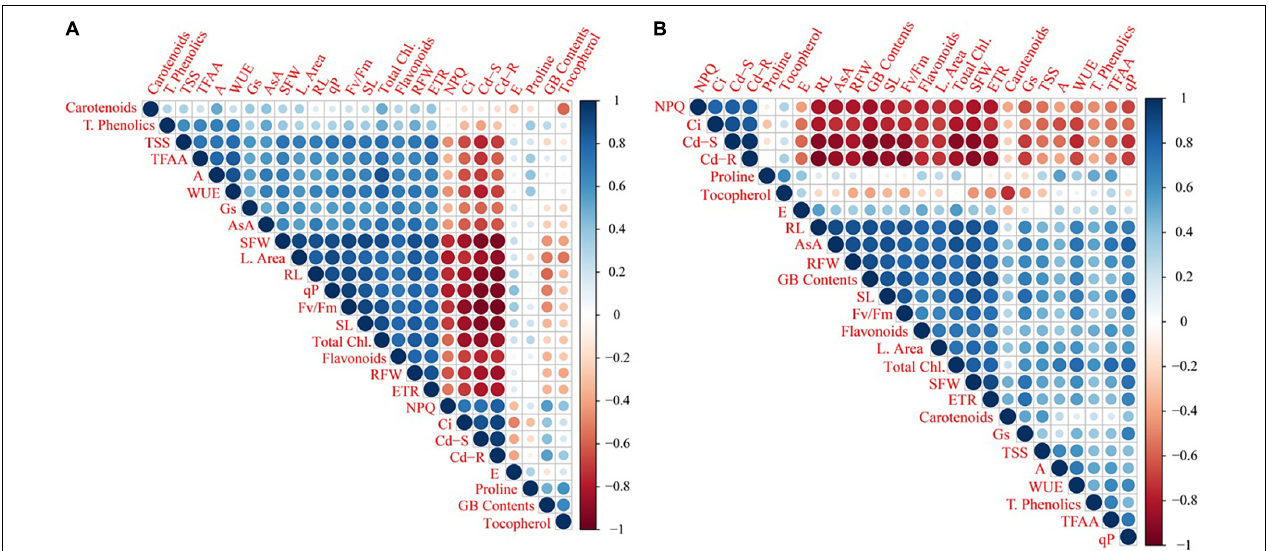
FIGURE 6 | The relative correlation analysis among growth and physio-biochemical attributes of two wheat cultivars, i.e., Fsd-08 (A) and Glxy-13 (B) , under the foliar spray of AsA and MLE, along with NS treatments. The blue and red colors indicate positive (+) and negative (-) correlation, whereas size of circle and color deepness indicates the intensity (stronger or weaker) of correlations at P < 0.05, respectively. The abbreviations are as following: qP: photochemical quenching; TFAA: total free amino acid contents; WUE: water use efficiency; TSS: total soluble sugars; ETR: electron transport rate; SFW: shoot fresh weight; RFW: root fresh weight; Fv/Fm: